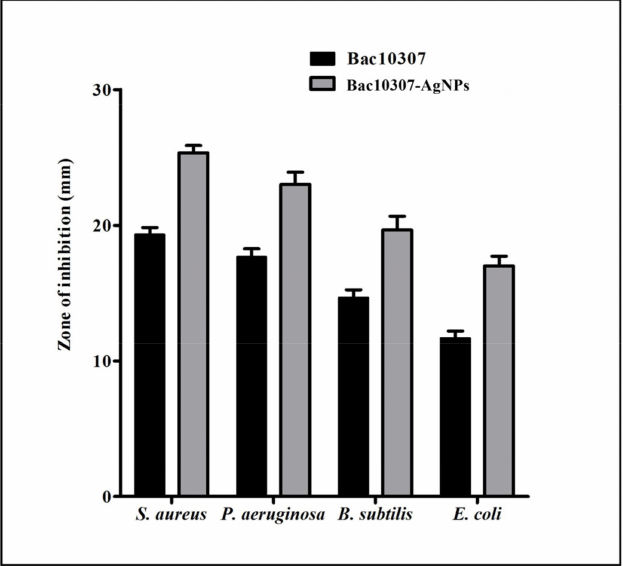
Figure 1. Antibacterial activity (zone of inhibition) of Bac10307 and Bac10307-capped AgNPs against S. aureus , P. aeruginosa , B. subtilis, and E. coli . The test was carried out in triplicate, and the data represent the mean ± SD, n =